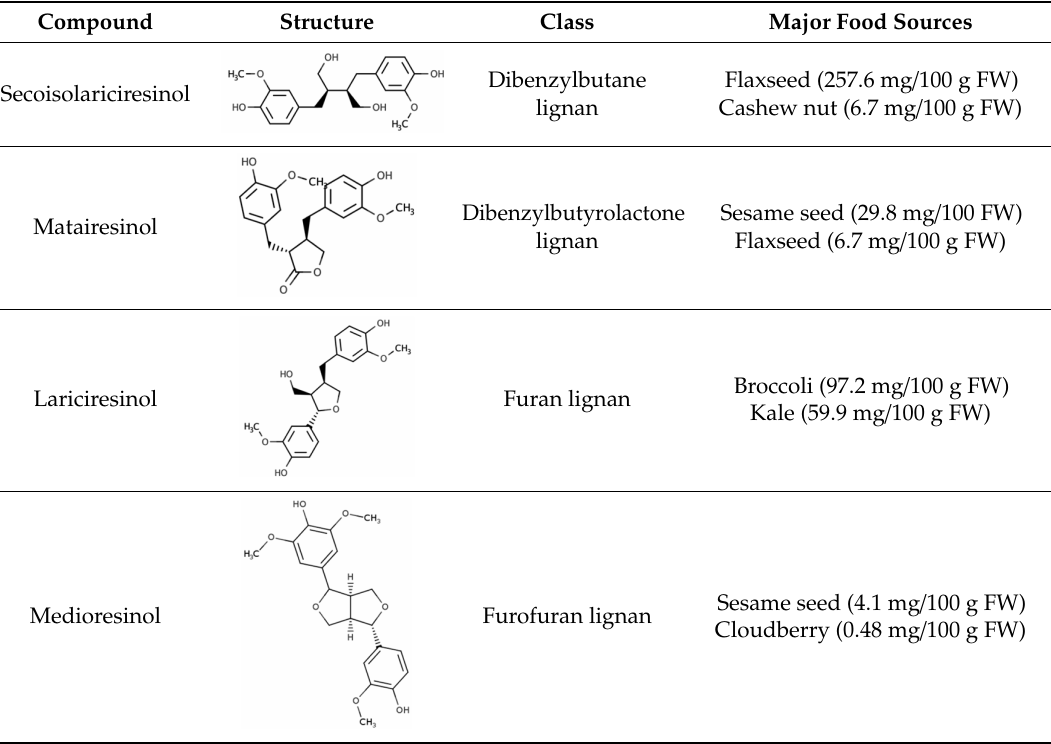
Table 1. Most common lignans in plant foods, together with their structure, class, and major sources, according to the comprehensive Phenol-Explorer database